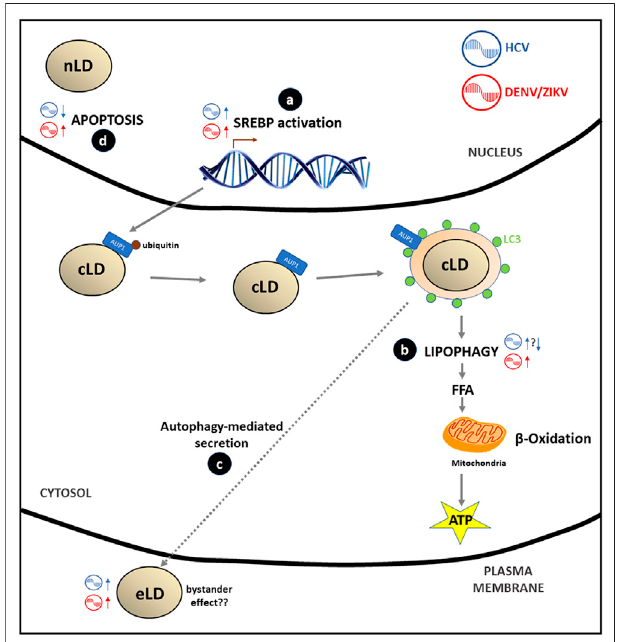
FIGURE 4 | Flaviviridae effects in LD metabolism: (A) HCV, ZIKV/DENV stimulate the SREBP pathway through the transcription of genes involved in LD and lipids biosynthesis in order to cover the extra membrane requirement that virus replication generates. (B) DENV/ZIKV stimulates lipophagy by recruitment of deubiquitinated AUP1 from LD membrane to the LC3-positive autophagosome; this process generates FA that after catabolism inside the mitochondria ( β -oxidation) produce energy (ATP) to accomplish viral replication. Data on the HCV effect on lipophagy are controversial: some authors report a stimulation of this process while other suggest that inhibition oflipophagymay occur. (C) Some authors hypothesizethatthere isaputative secretion of HCV or DENV/ZIKV virions, viral proteins or infectious viral RNA mediated by autophagy of LC3-positive LD vesicles (eLD) to spread the infection. This phenomenon may support the bystander effect proposed for DENV/ZIKV infections. (D) Apoptosis is inhibited (HCV) or stimulated (DENV/ ZIKV) by viral and nLD interaction with PML nuclear